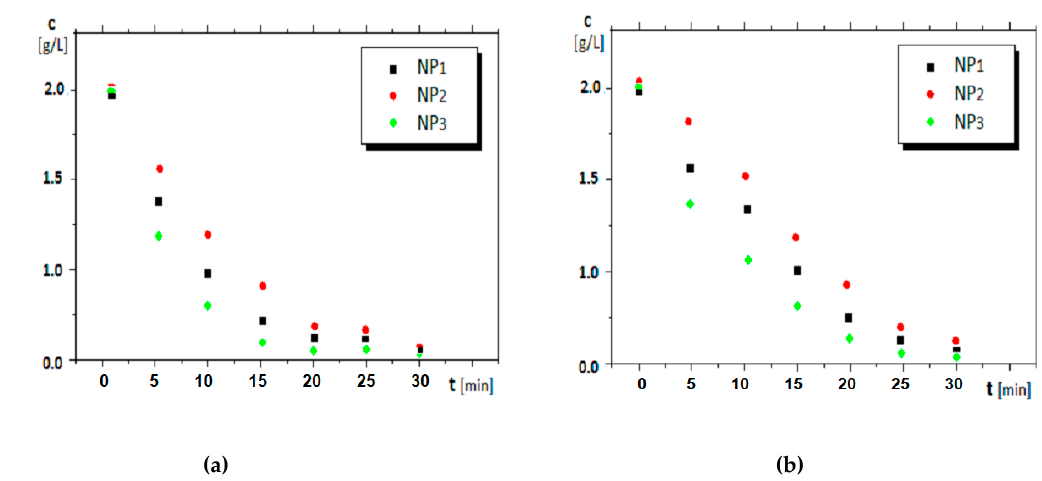
Figure 6. The source phase variation during the operation at a constant magnetic stirring regime (40 oscillations/min) for the three types of nanoparticles in n- decanol: ( a ) o -nitrophenol and ( b ) m -nitrophenol.